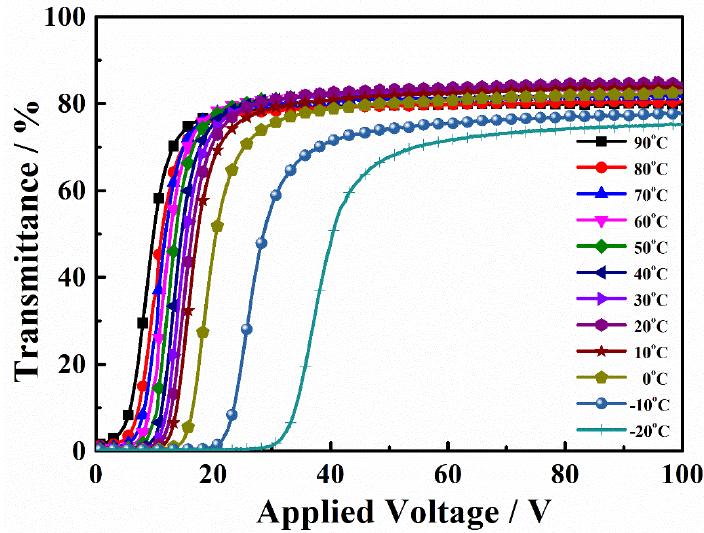
Figure 7. The temperature-dependent relationship between PDLC film transmittance and applied voltage.